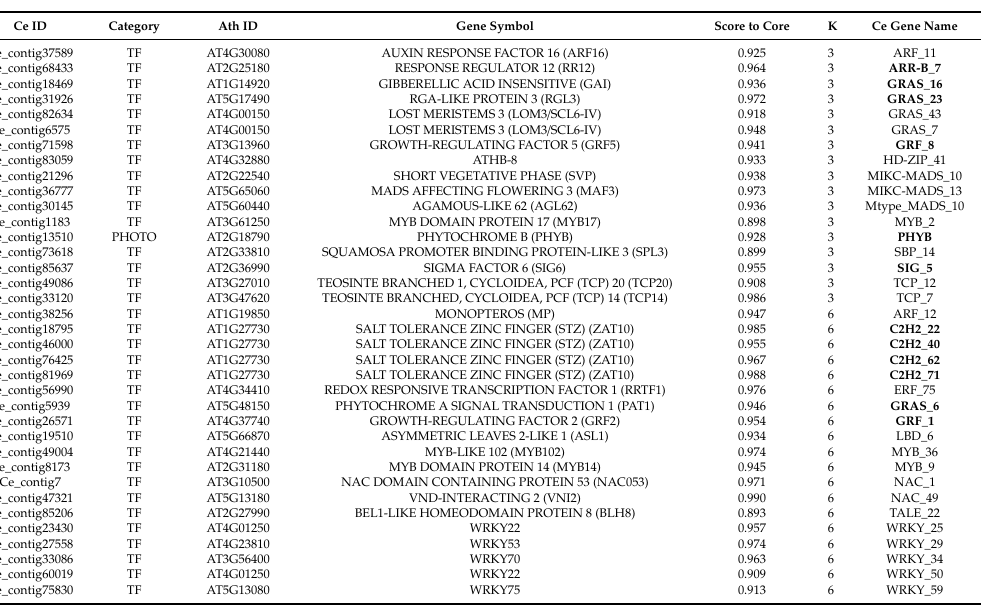
Table 2. List of developmental genes of interest found in cluster three and six that were selected amongst those having a high score to core. Known genes involved in photosynthesis regulations are in